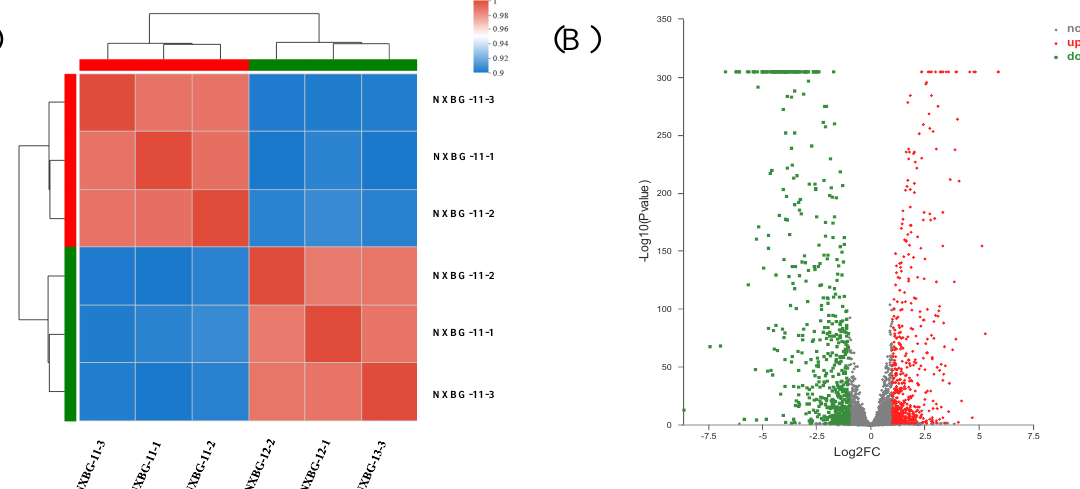
Figure 3. ( A ) Sample correlation analysis. Squares with different colors represent correlation between the two samples. ( B ) DEG volcano map. The abscissa is the multiple change value of gene expression difference between two groups of samples, namely FC value. The ordinate is the statistical test value of the difference in gene expression changes, namely the p -value.